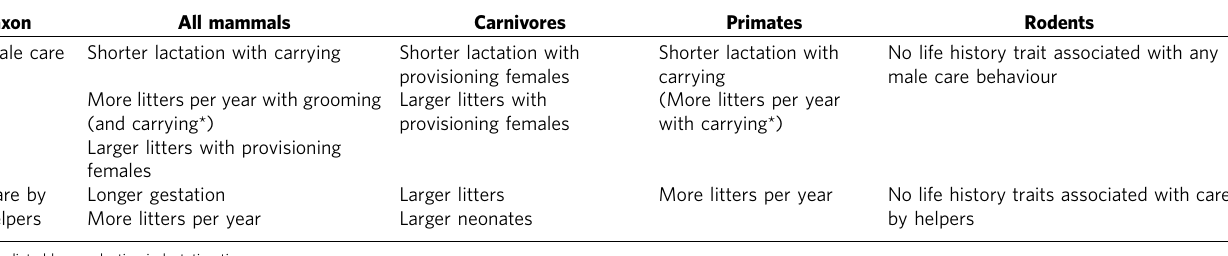
Table 3 | Summary of main results for male care and care by other helpers across all mammals, carnivores, primates and